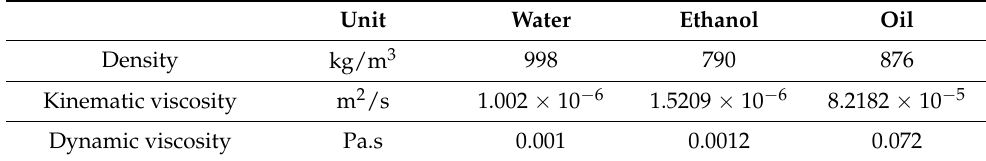
Table 1. Physical properties of common liquids.